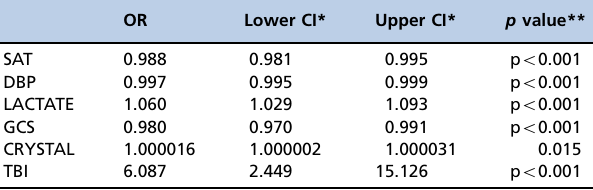
Table 4 - Generalized estimating equation model for death as a function of the main effects of the measures performed over the 4 time